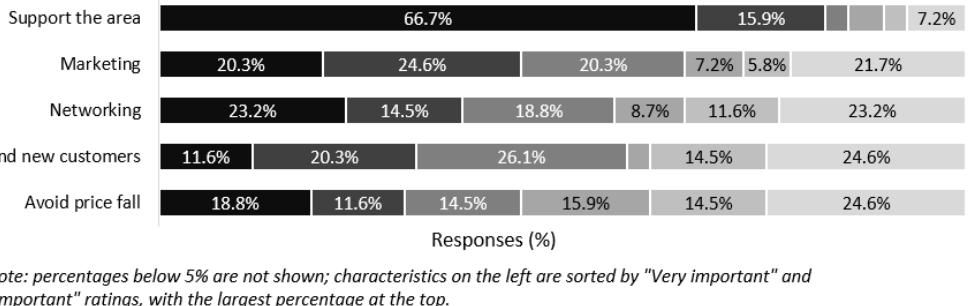
Figure 4. Importance of the reasons why respondents adhered to the PEFC supply chain; N = 69. Table 2. Reasons for adhering to the system. Goodness of fit test: Comparison of grouped re- sponses from all respondents with expected uniform distributions of responses. Fischer ’s exact test: A ssociations between organizations’ categor ies and reason s’ ratings. Significance set at a level of 0.05.